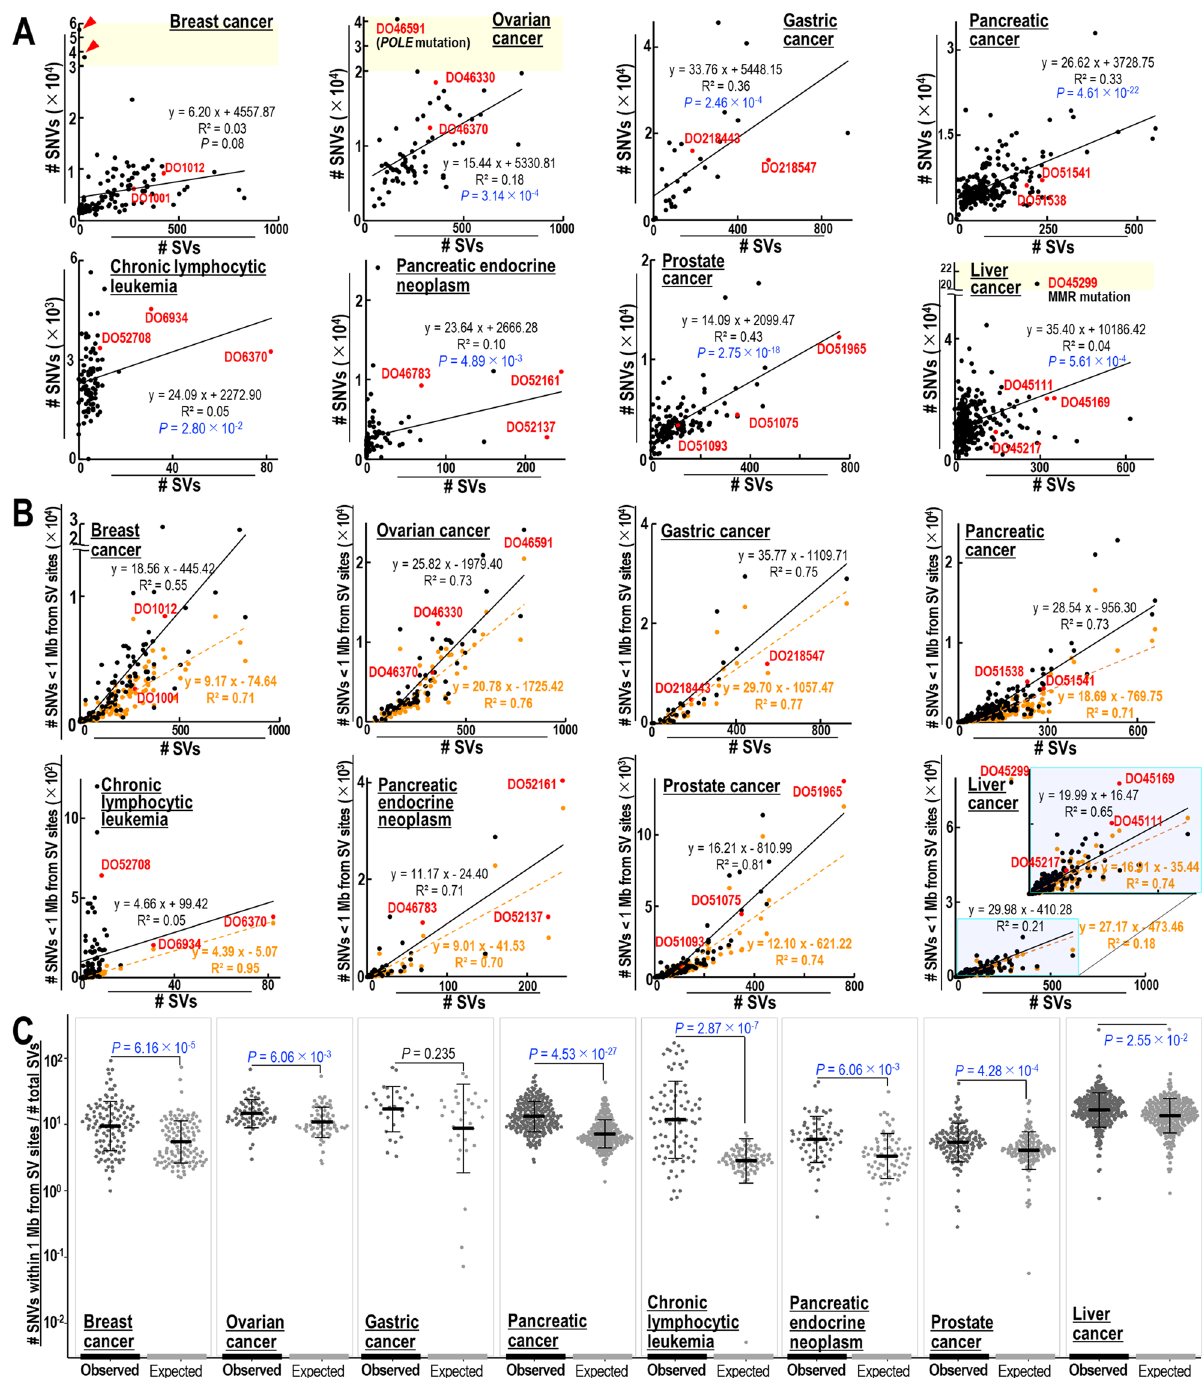
Figure 1. SV-associated SNV induction observed in breast, ovarian, gastric, pancreatic, prostate, and liver cancers, chronic lymphocytic leukemia, and pancreatic endocrine neoplasm. ( A ) Relationship between the numbers of SNVs and the numbers of SVs induced in individual tumors of each organ. Statistical analysis by two-tailed t -tests. ( B , C ) Comparisons of the numbers of SNVs within 1 Mb of each SV site in individual tumors of each organ with the numbers of SNVs randomly expected ( B ). Expectations were estimated based on a random distribution across detectable SNV sites within the whole genome (orange dotted line). Comparisons of relative SNV rates within 1 Mb of each SV site in individual tumors of each organ with the relative SNV rates randomly expected ( C ). Statistical analyses by two-tailed t